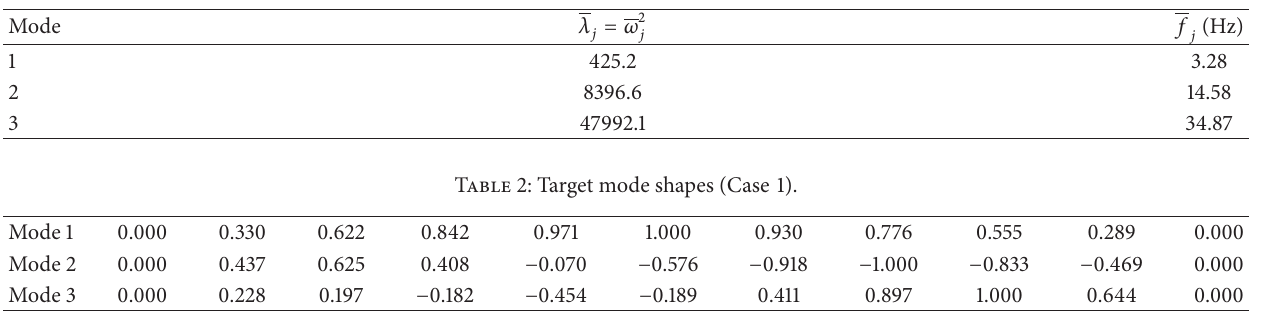
Table 1: Target frequencies (Case 1).